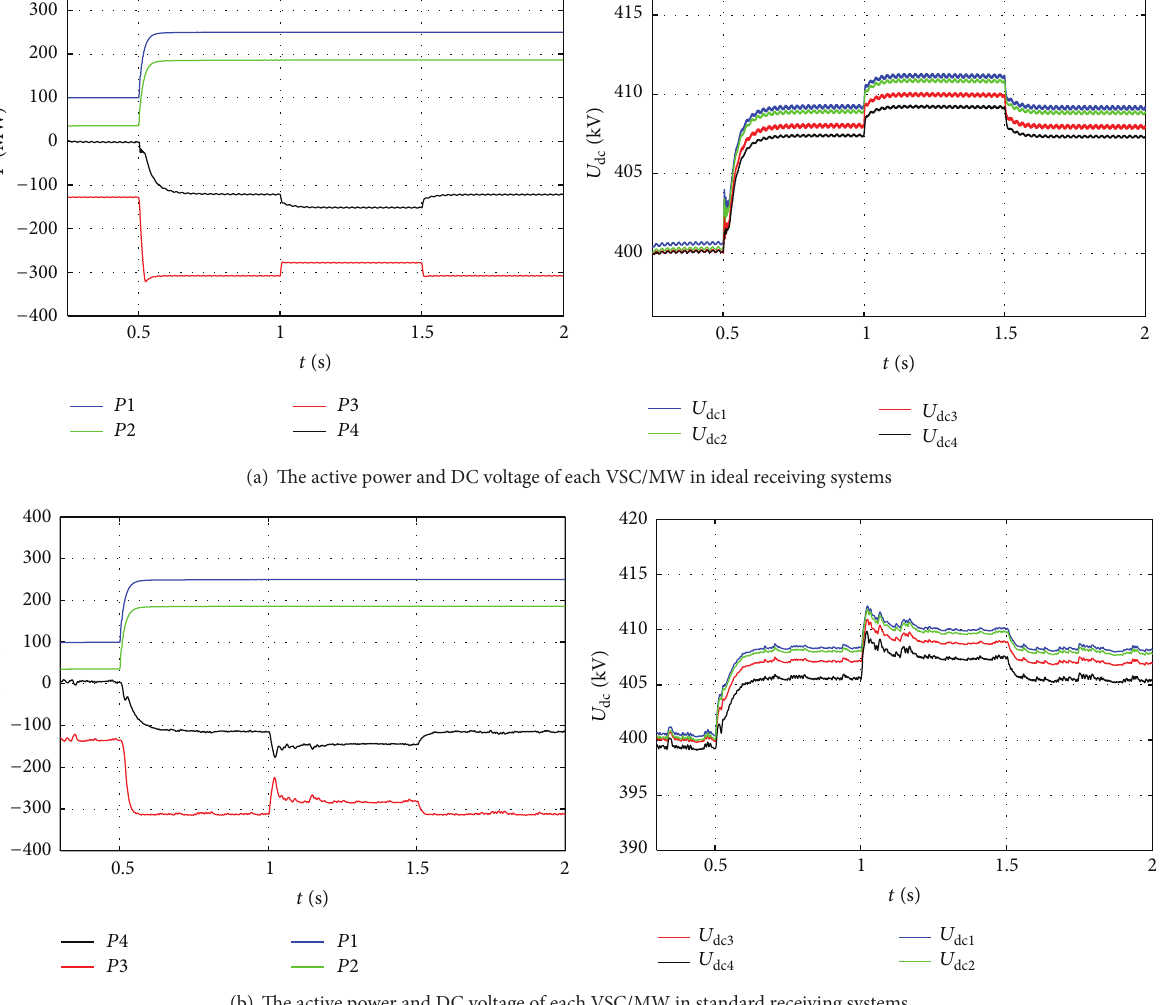
Figure 8: Simulation of variation of transmission power ratio of